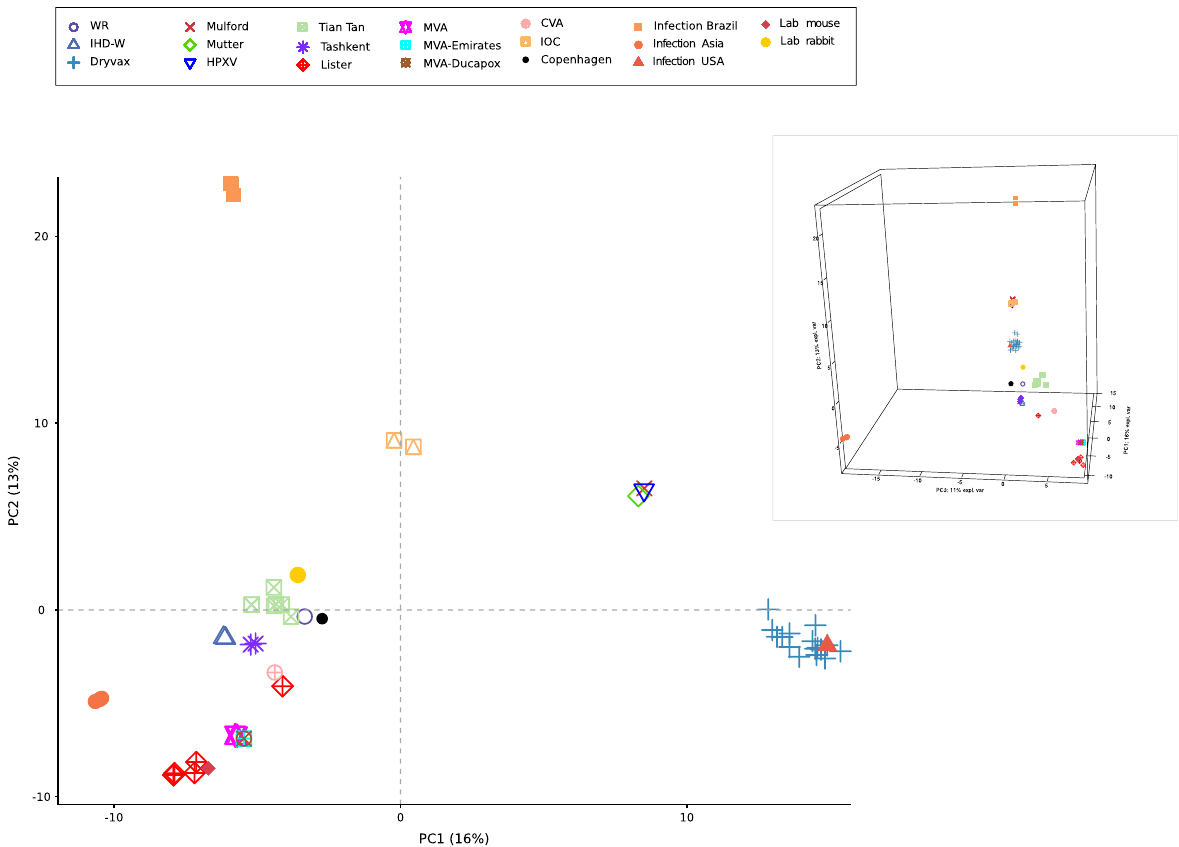
Fig. 2 PCA of vaccinia virus genomes. A principal component analysis of VACV samples is shown. Each VACV group/type is colored and displayed with a different symbol, as described in the legend. The two fi rst PCs are plotted in the large fi gure. In the insert, the two axes (PC1 and PC2) are rotated to visualize the contribution of